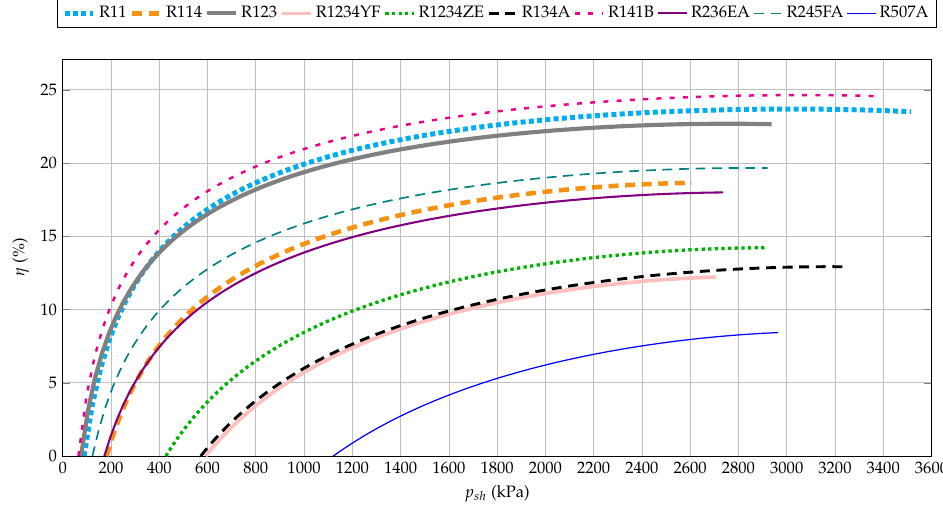
Figure 4. Performance evolution considering real